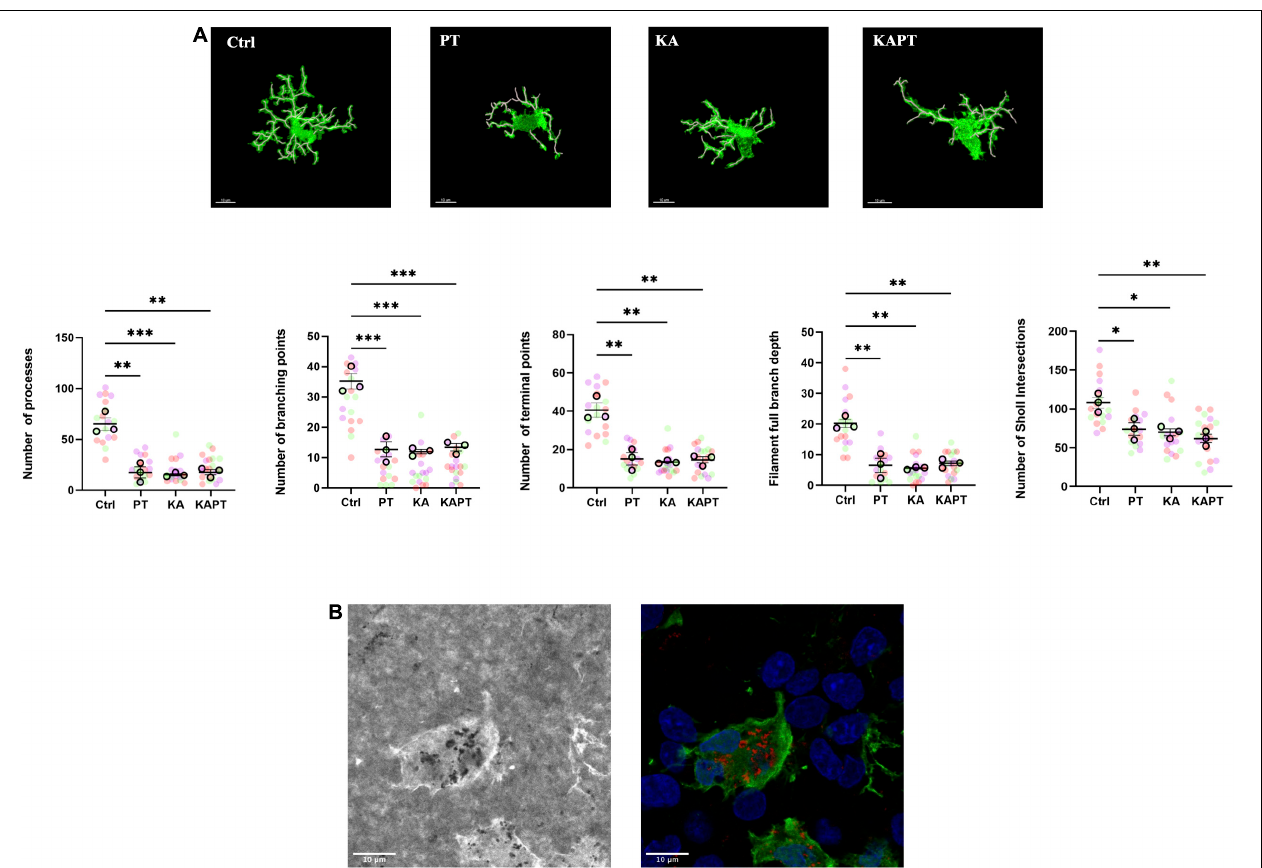
FIGURE 6 | Platinum nanoparticles (PtNPs) cause morphological alterations of microglia after 24 h of contact. (A) Representative Iba-1 immunostaining of microglia at 63X magnification, showing alteration in microglia morphology in all the treatment groups compared to controls. White cylinders highlight branch complexity. Bottom charts represent microglia morphology quantification showing significant differences in the number of processes, branching and terminal points, as well as the branch complexity and ramification in all the treatment groups compared to controls. (B) Left: representative brightfield image showing PtNPs internalization by microglia. Right: merge of the brightfield image with PtNPs colored in red with the fluorescent image showing microglia in green and nuclei in blue. Dots in the dot plots represent individual cells. Data are presented as means ± standard error of the mean (SEM) ( n = 3 independent experiments; 5–8 cells analyzed per group/experiment). Tukey’s test after one–way analysis of variance (ANOVA) was used for statistical analysis. ∗ p < 0.05; ∗∗ p < 0.01; ∗∗∗ p <